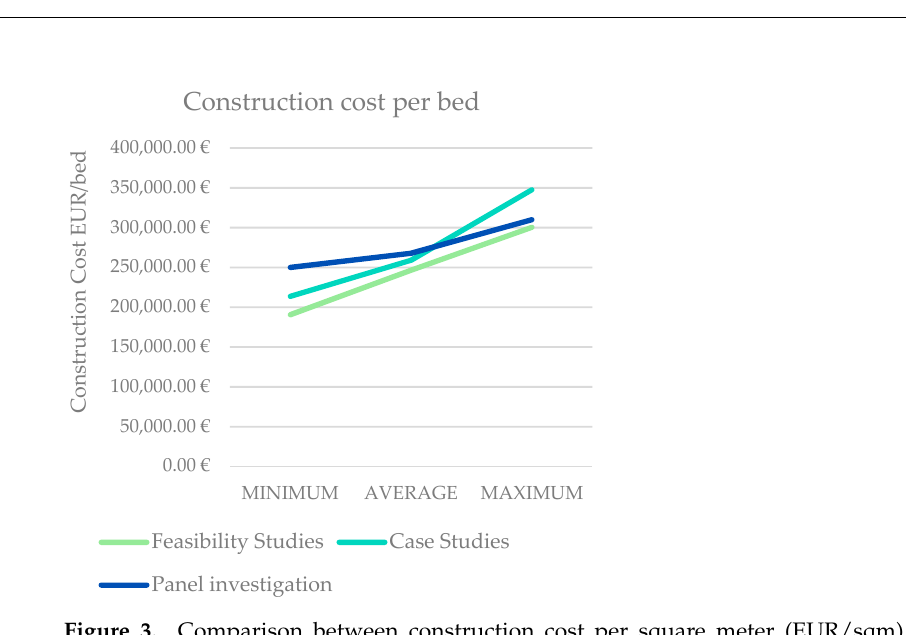
Figure 3. Comparison between construction cost per square meter (EUR/sqm) and per bed (EUR/bed) expressed in feasibility studies (literature), case studies and panel investigation.